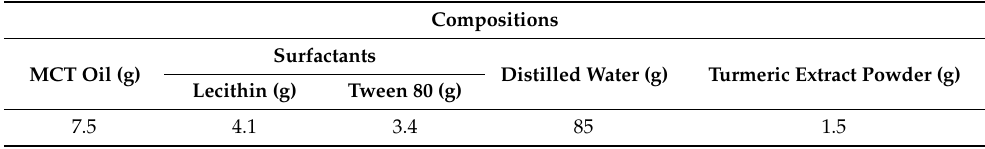
Table 1. Compositions of the turmeric extract-loaded